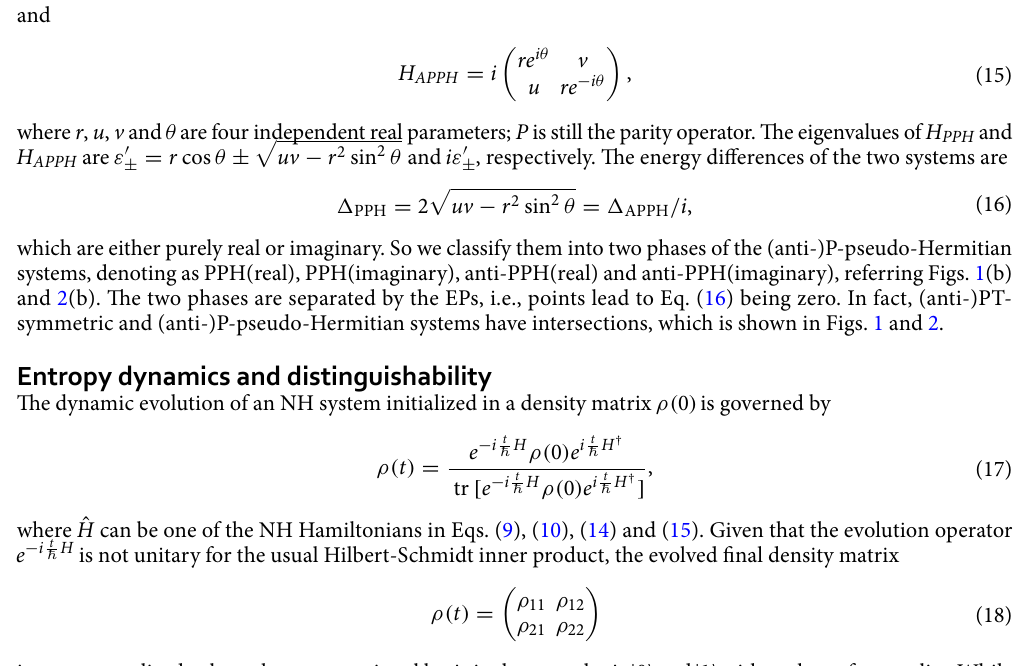
Figure 2. Parameter spaces of anti-PT-symmetric and anti-P-pseudo-Hermitian systems. From Eqs. (10) and (15), both the anti-PT and anti-PPH systems contain four parameters. Here we use the parameter space to illustrate the phase diagram of the two NH systems. ( a ) Anti-PT systems. The parameter space is described by s , w and θ (here we set r = 2 ). There are anti-PT(unbroken/imaginary) and anti-PT(broken/real) phases, EPs (the curved surface satisfying (cid:31) APT = 0 ), and intersections with anti-PPH (the yellow plane of w = 0 ) systems. ( b ) Anti-P-pseudo-Hermitian systems. The parameter space is described by u , v and θ (here we set r = 2 ). The saddle surface are of EPs ( (cid:31) APPH = 0 ), separating H APPH ’s with imaginary and real eigenvalue-differences which we denote as anti-PPH(imaginary) and anti-PPH(real) phases in the main text. The yellow plane of u = v is the intersection of anti-PPH and anti-PT systems, while the red line indicates the intersection of anti-PPH and Hermitian and